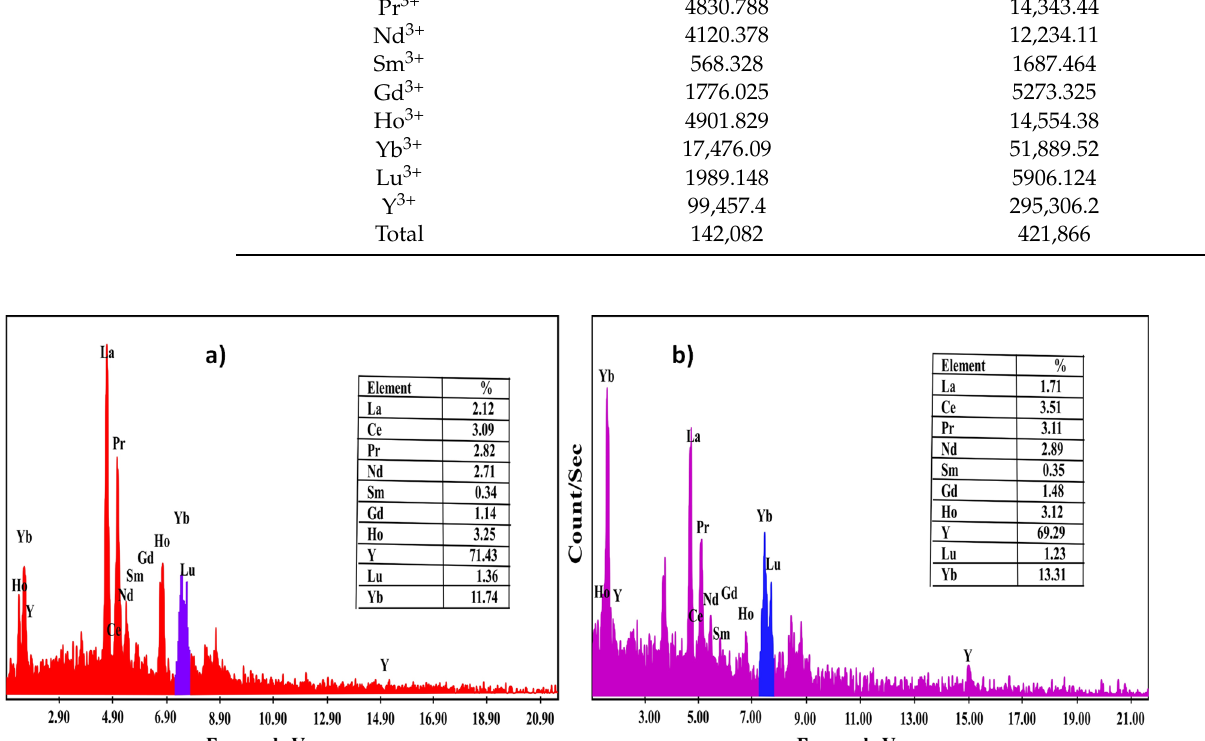
Figure 11. ( a ) The environmental scanning electron microscope of rare earth oxalate from REEs/PVC. ( b ) The environmental scanning electron microscope of rare earth oxalate from REEs/CBP/PVC.